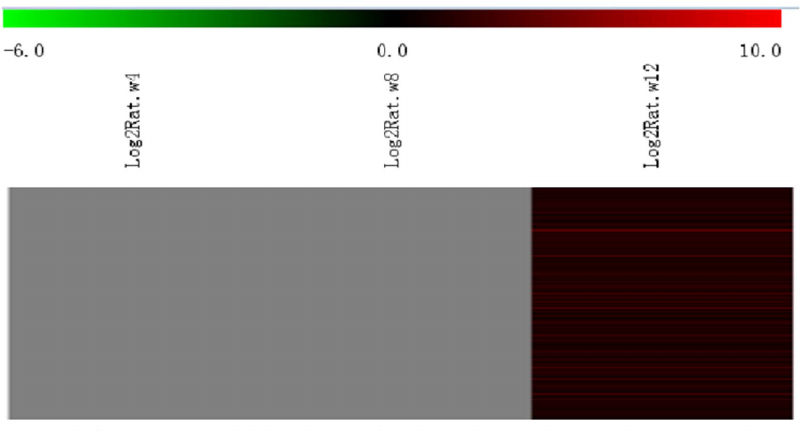
Figure 6. The Heat Map and the list of genes which were up-regulated at the late stage (12 weeks of age). There were a total of 1583 genes in the list.